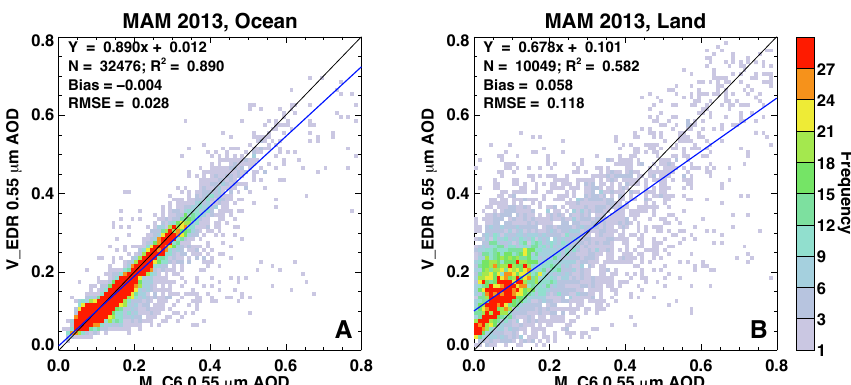
Figure 4. Comparison of mean AOD in collocated grids from the Spring 2013 maps (e.g., Fig. 2), for ocean retrievals (a) and land re- trievals (b) . Statistics (regression equation, number of collocated grids, correlation, bias and RMSE) are provided as text in each